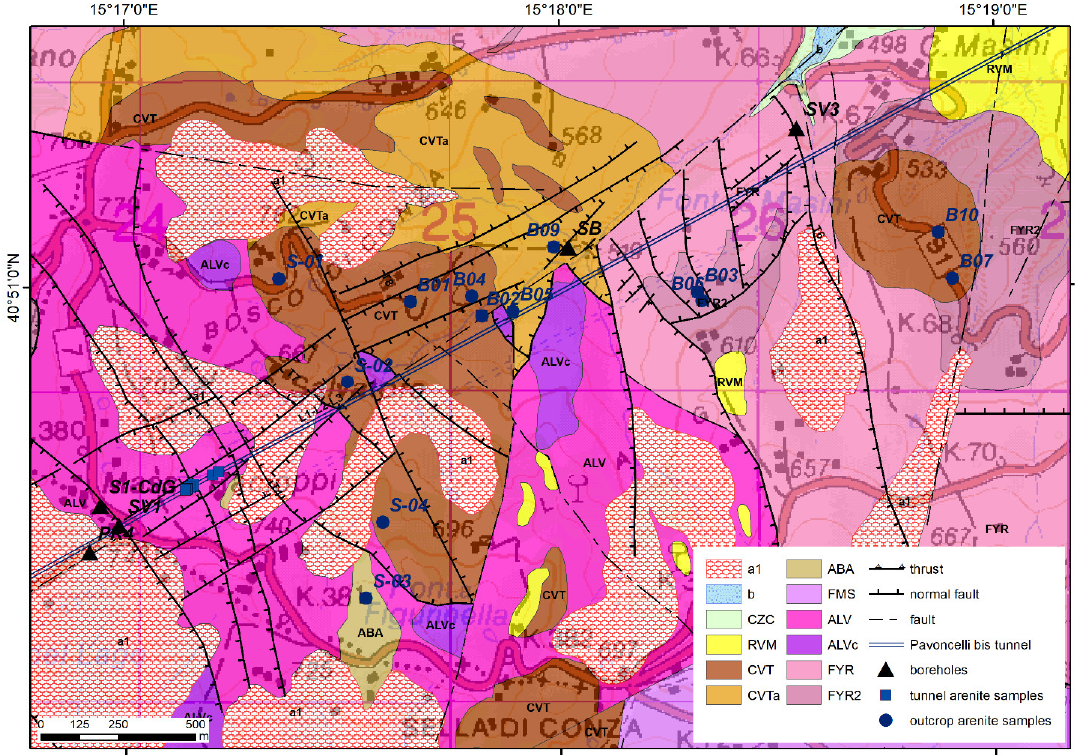
Figure 8. Detail of the Geological map of the Sella di Conza sector of study area with borehole and sample location. For legend unit codes, see Figure 4 caption.